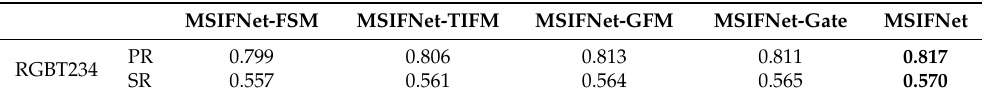
Table 3. The PR/SR scores of our method were compared with variants on the RGBT234 datasets to verify the validity of the proposed modules.